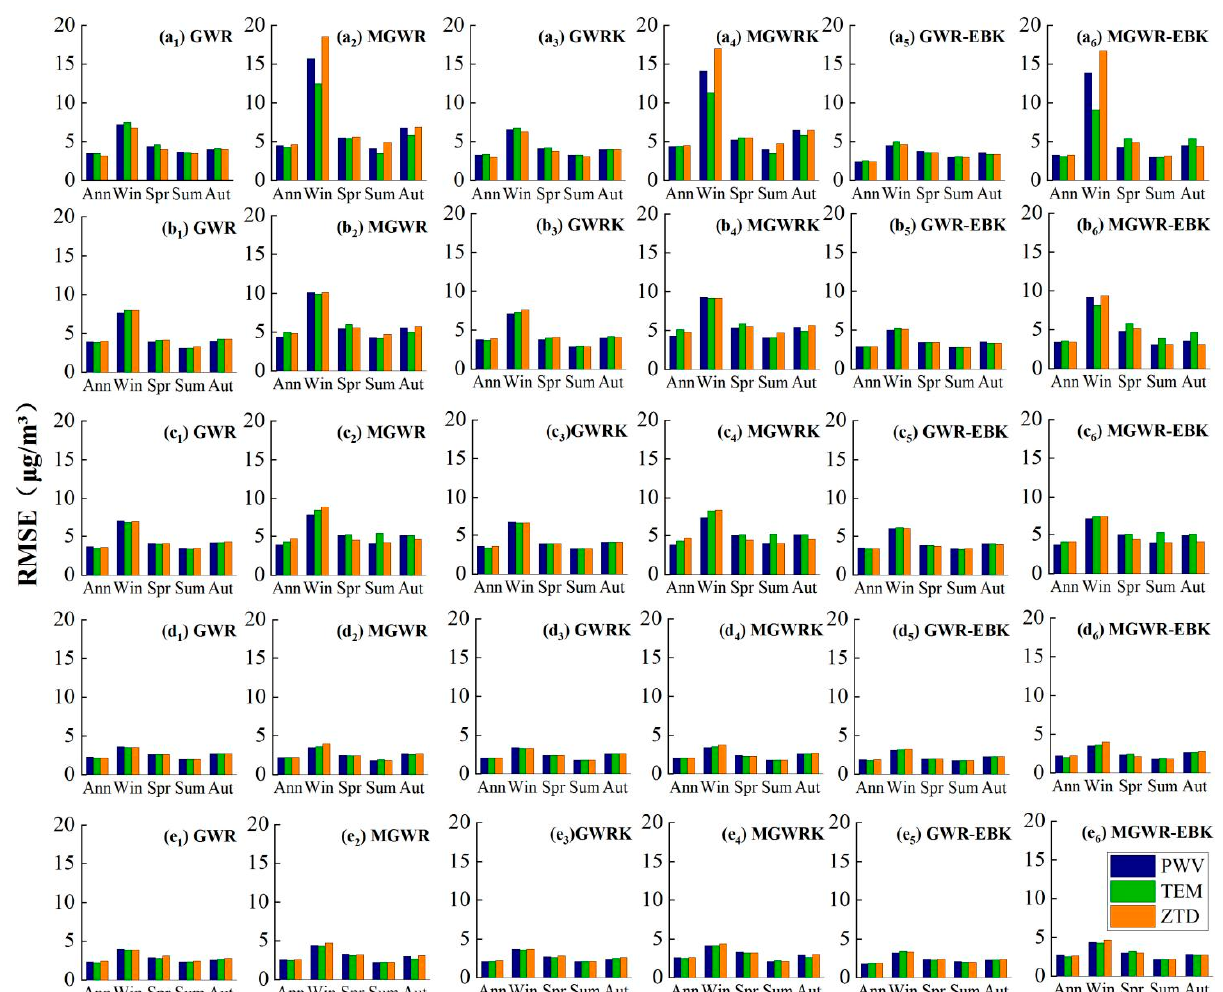
Figure 14. Model RMSEs for different provinces: ( a ) Henan, ( b ) Hubei, ( c ) Hunan, ( d ) Guangdong, ( e ) Guangxi.